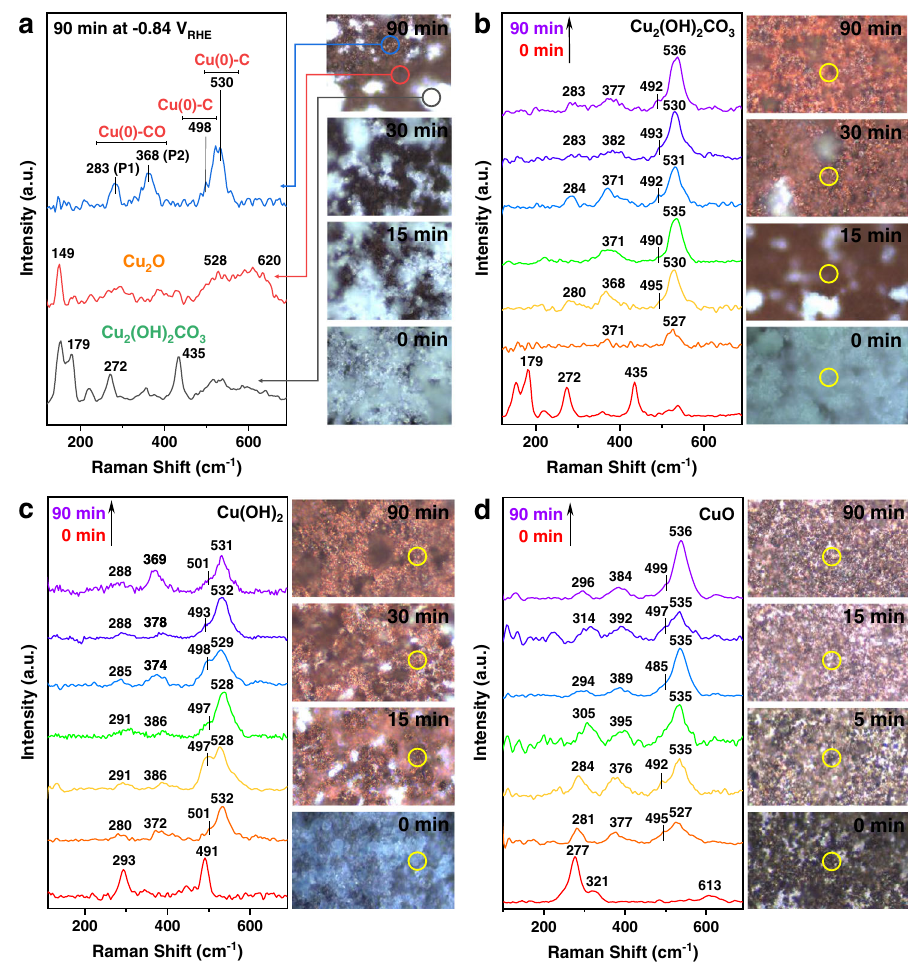
Fig. 4 | The operando Raman spectroscopy characterizations. a Time-resolved lightmicroscopy(rightpanel)imagesoftheCu 2 (OH) 2 CO 3 electrodesurfaceduring the CO 2 RR process at − 0.84V RHE , and the operando Raman spectra (left panel) acquiredfromthreedifferentareas(circledindifferentcolors)ontheCu 2 (OH) 2 CO 3 electrode surface after 90min of the reaction. Time-resolved operando Raman